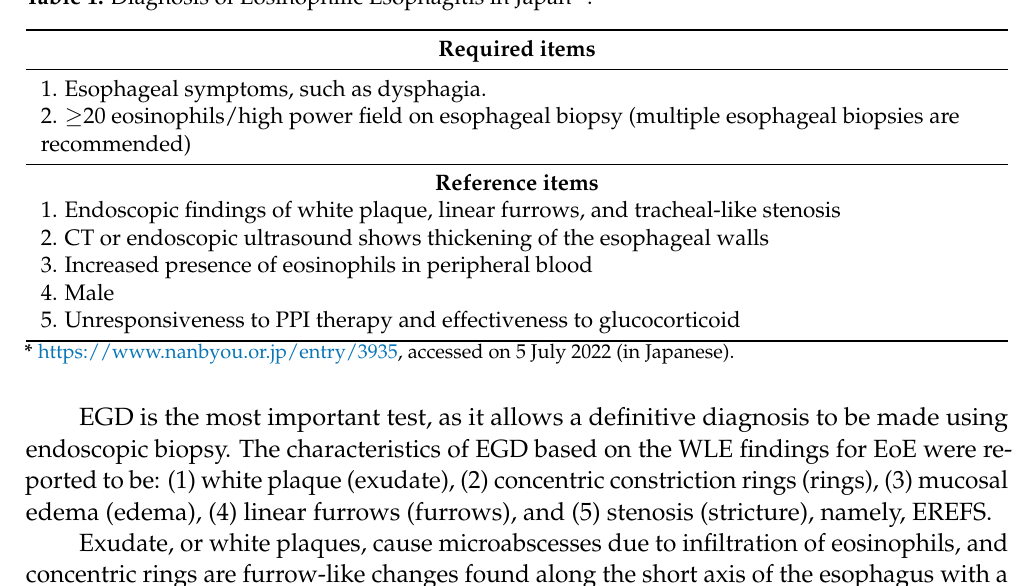
Table 1. Diagnosis of Eosinophilic Esophagitis in Japan *